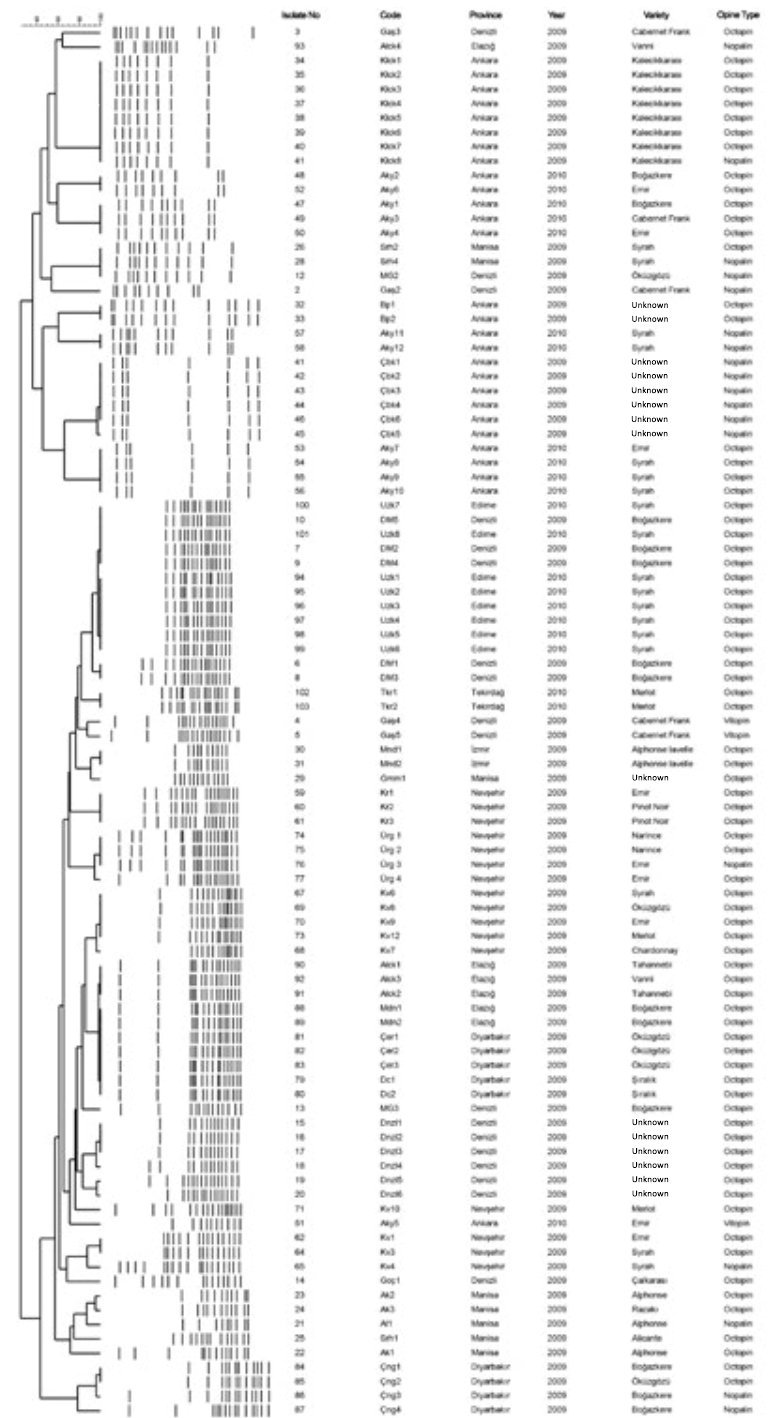
Figure 5 . Dendrogram displaying genotypic differences of a Turkish Rhizobium vitis population. Percent similarity was calculated by the Dice similarity of PFGE ( Pme I) restriction endonuclease digestion, constructed using UPGMA algorithm (Bionumerics version 6.01 software) based on 1.5% tolerance value and 1% optimization